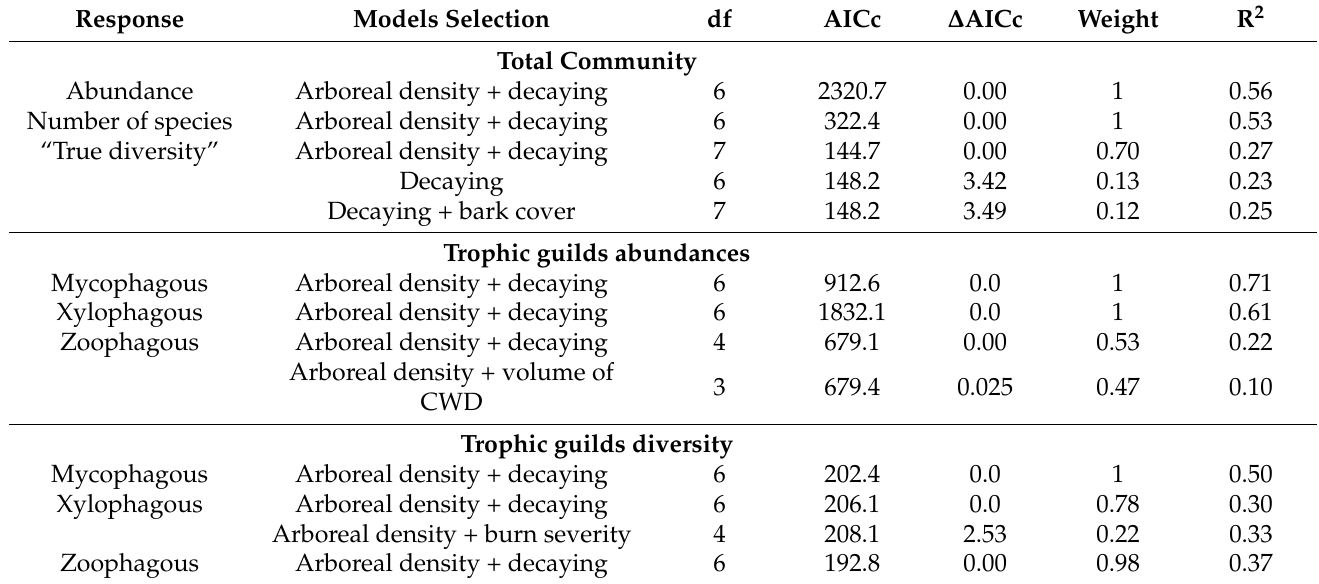
Table 4. The best-supported ( ∆ AIC < 4) generalized linear models (GLM) testing for the effects of habitat variable on the species richness and abundances of total community, and the different trophic guilds number of species and abundances of saproxylic